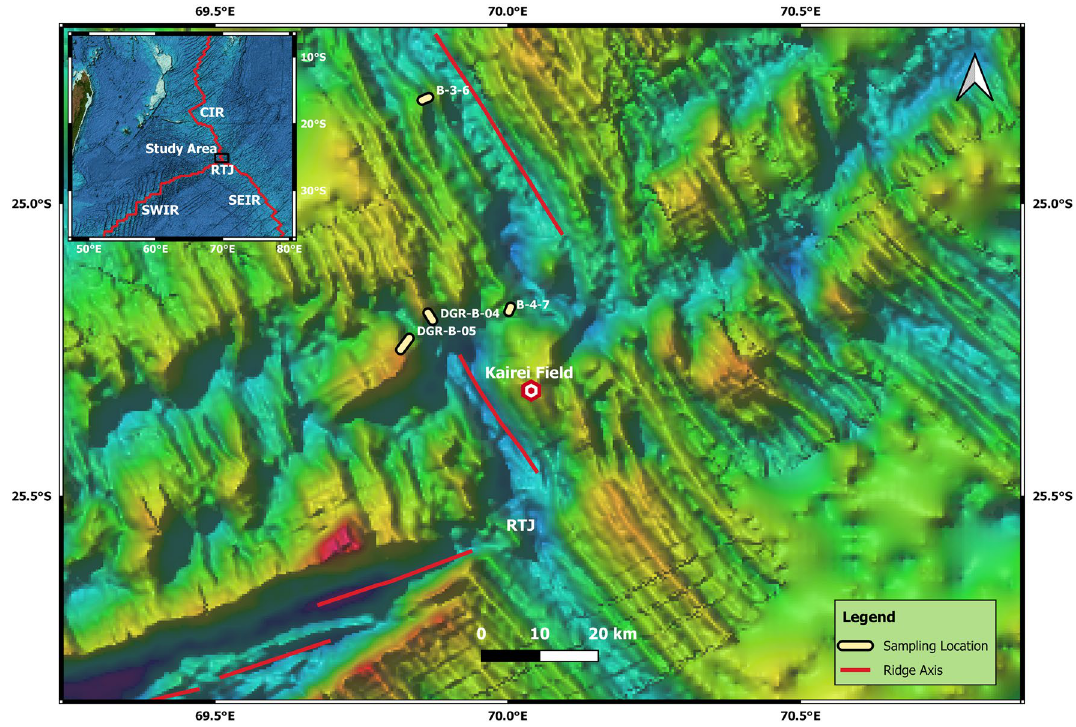
Figure 1. Bathymetry map of the study area showing sample location and known vent fields. Data is taken from the General Bathymetric Chart of the Oceans (GEBCO),